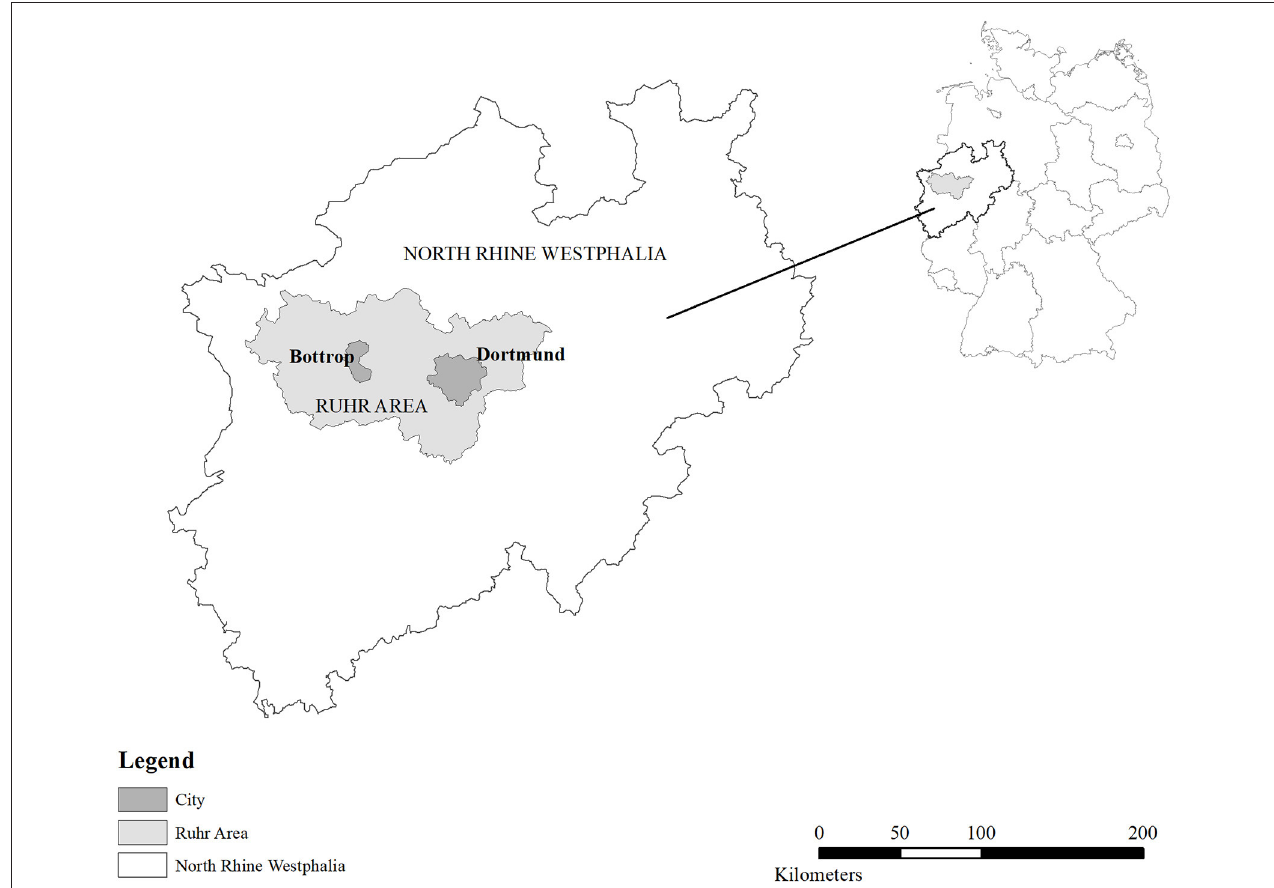
FIGURE 1 | Ruhr area in